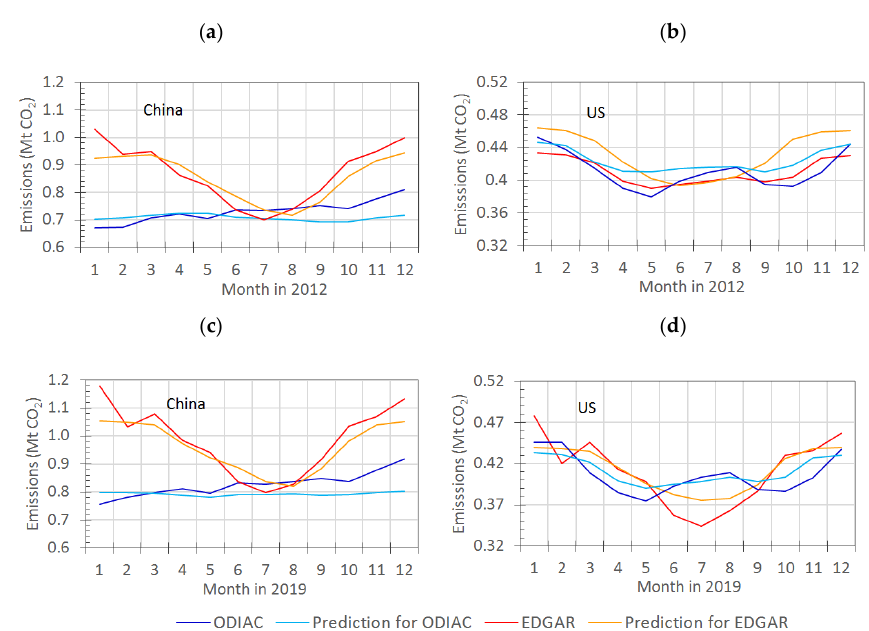
Figure 6. Seasonal cycles of emissions and predictions in ODIAC and EDGAR illustrated by the monthly average in 2012 for ( a ) China and ( b ) the USA, and in 2019 for ( c ) China and ( d ) the USA. The monthly time series of inventory emissions in ODIAC were created from 2011 to 2020 using the climatological seasonality based on the 2013 version of the CDIAC monthly gridded emissions which only covered from 2000 to 2010. The monthly CDIAC data from